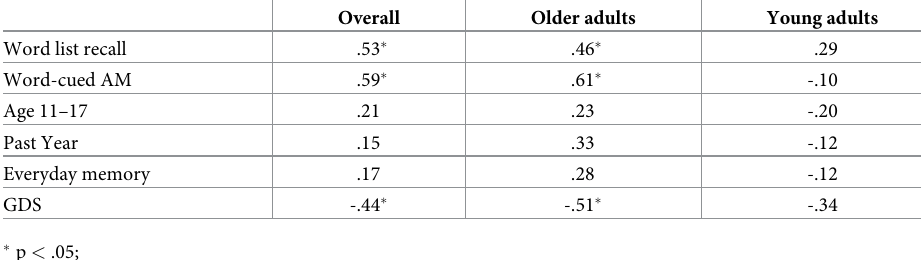
Table 7. Correlations between Matrix Reasoning scores, each memory measure, and